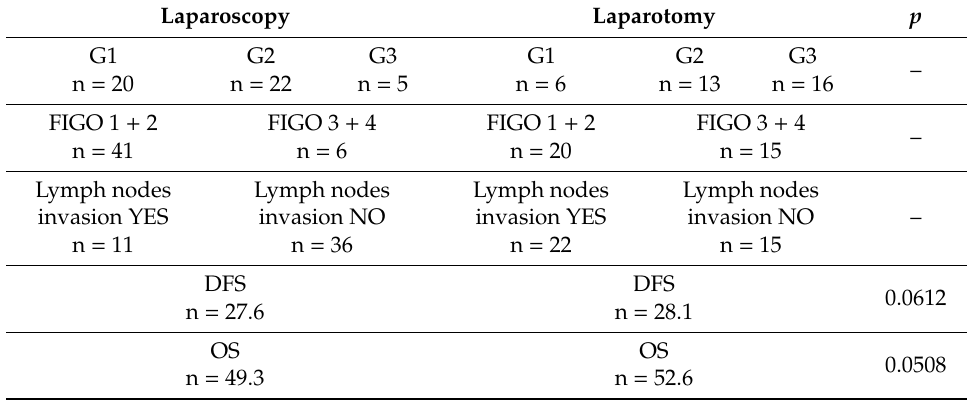
Table 6. Comparison between di ff erent subgroups of patients according to the type of surgery. Laparoscopy Laparotomy p G1 FIGO 1 + 2 FIGO 3 + 4 FIGO 1 + 2 FIGO 3 +